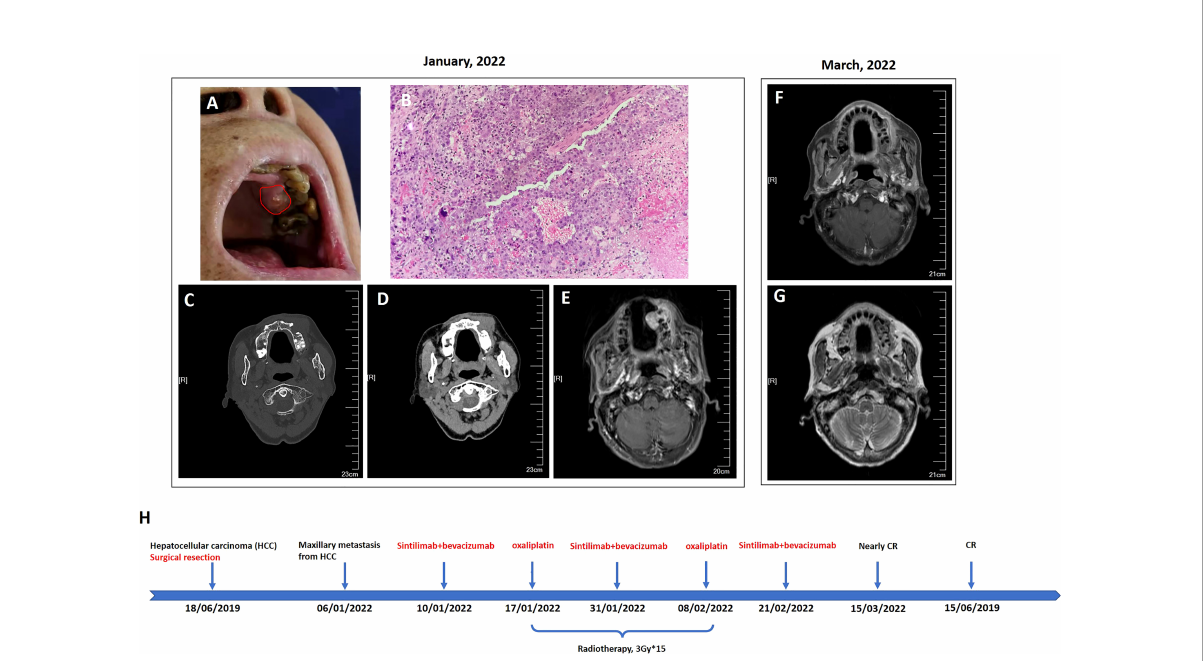
FIGURE 1 Oral examination revealed a mass on the upper left gingiva (A) , and head neck imaging indicated that it was an osteolytic lesion and formed a soft tissue mass protruding to the subcutaneous maxillo-facial region and oral cavity (C – E) ; fi nally, it was diagnosed as maxillary metastasis from HCC after biopsy of the mass in the oral cavity ( B , 200×). After comprehensive treatment of sintilimab plus bevacizumab biosimilar IBI305 plus radio- chemotherapy, the maxillary metastasis shrunk dramatically to nearly complete remission (F, G) . A time course of the entire case is shown in (H)